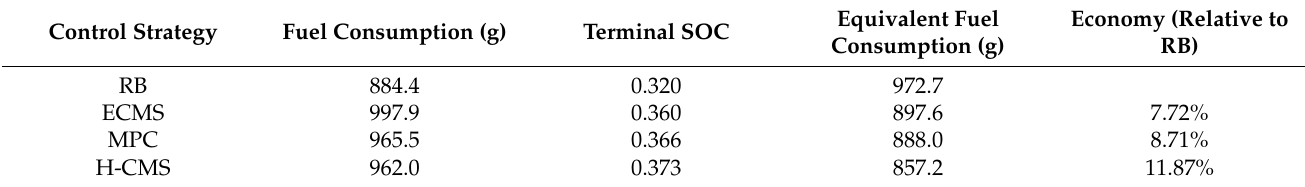
Table 5. Data comparison table under different strategies.